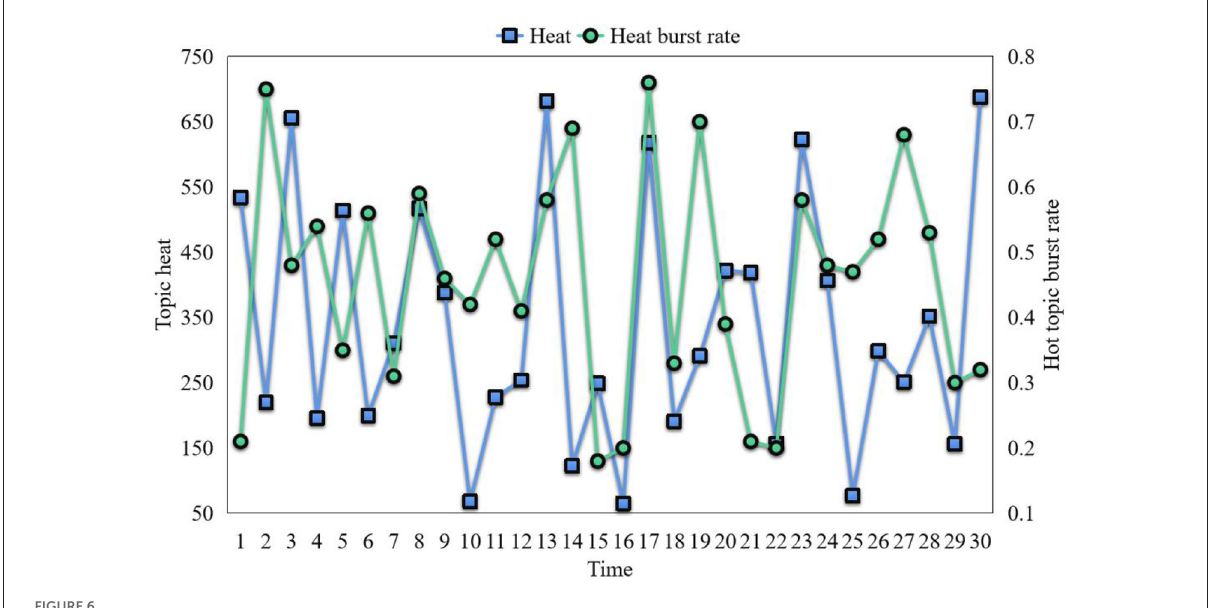
FIGURE6 Topic heat and heat mutation